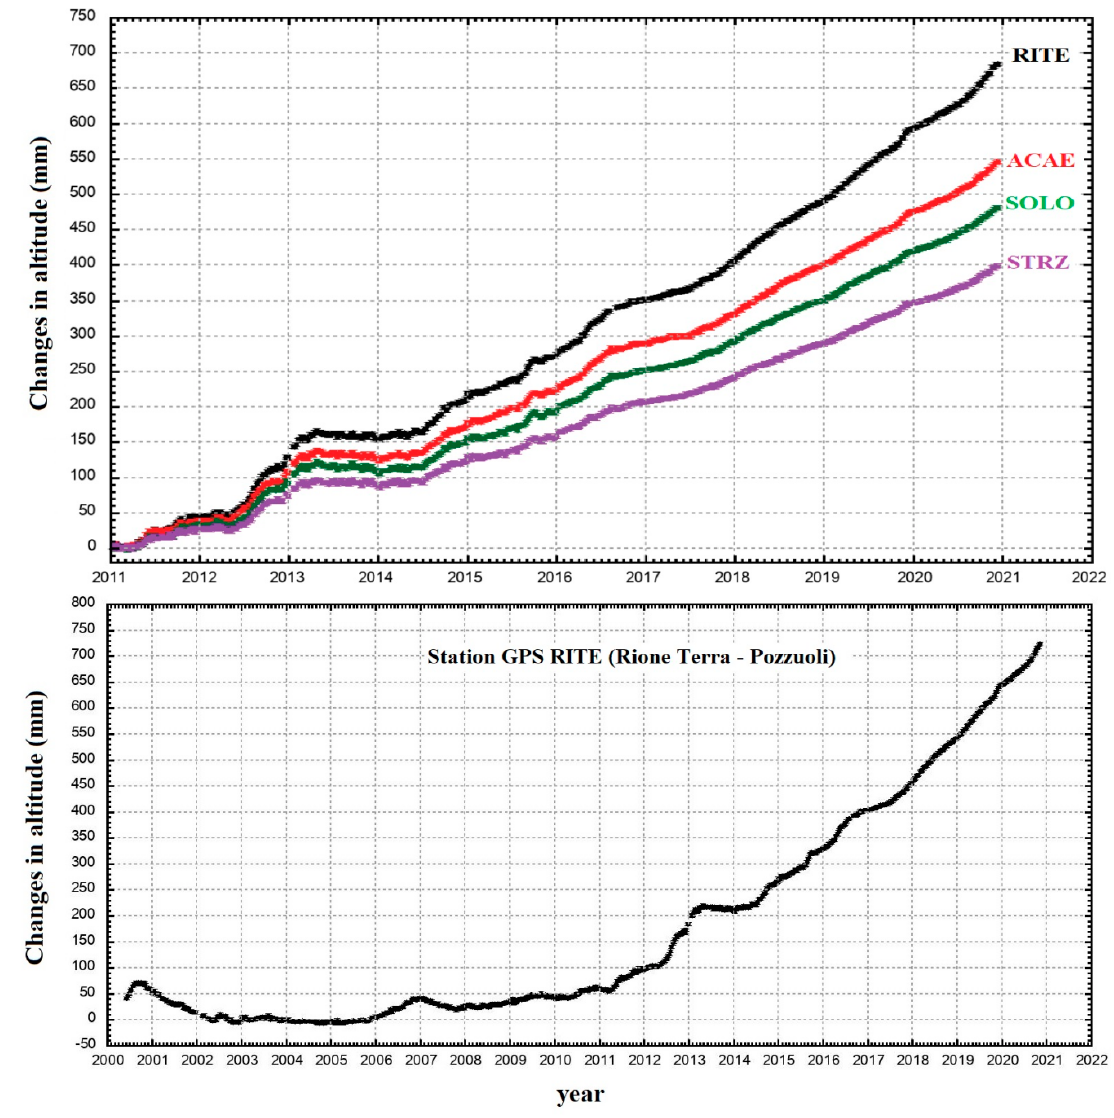
Figure A1. Time series of changes in altitude of the RITE station (Pozzuoli-Rione Terra), ACAE (Accademia Aeronautica), SOLO (Solfatara), and STRZ (Pozzuoli-Cemetery) from January 2000 to May 2020 (modified from: INGV-OV Bulletin of Surveillance Phlegraean Area, © CC BY-NC-ND